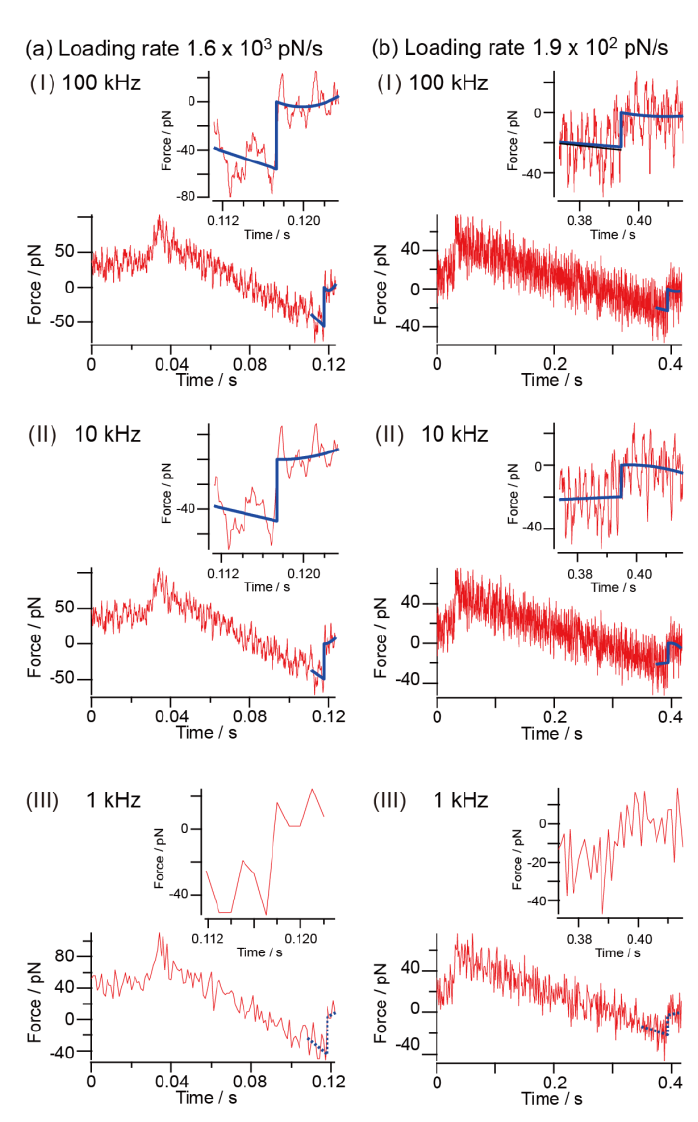
Figure 4. Force curves obtained at a sampling rate of 100 kHz for loading rates of 1.6 × 10 3 pN/s ((a)-I to (a)-III) and 1.9 × 10 2 pN/s ((b)-I to (b)-III), where force curves